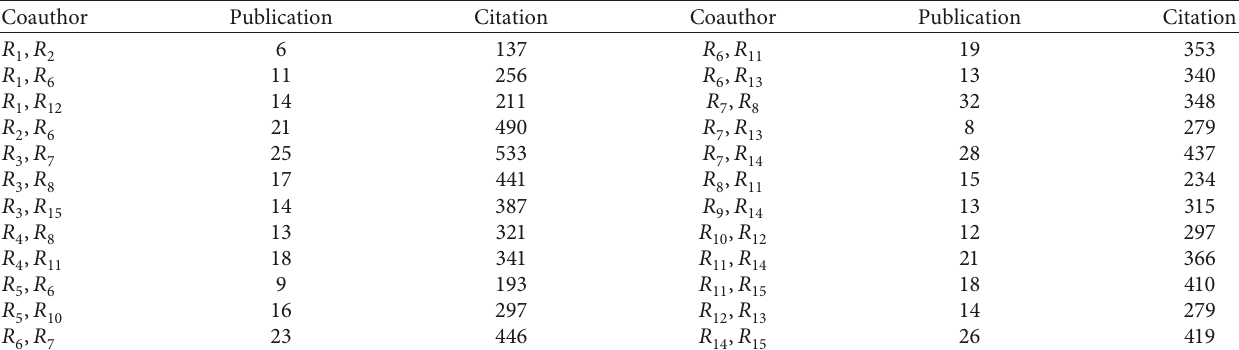
Table 3: Coauthors publications and citations since 1998 to 2016.